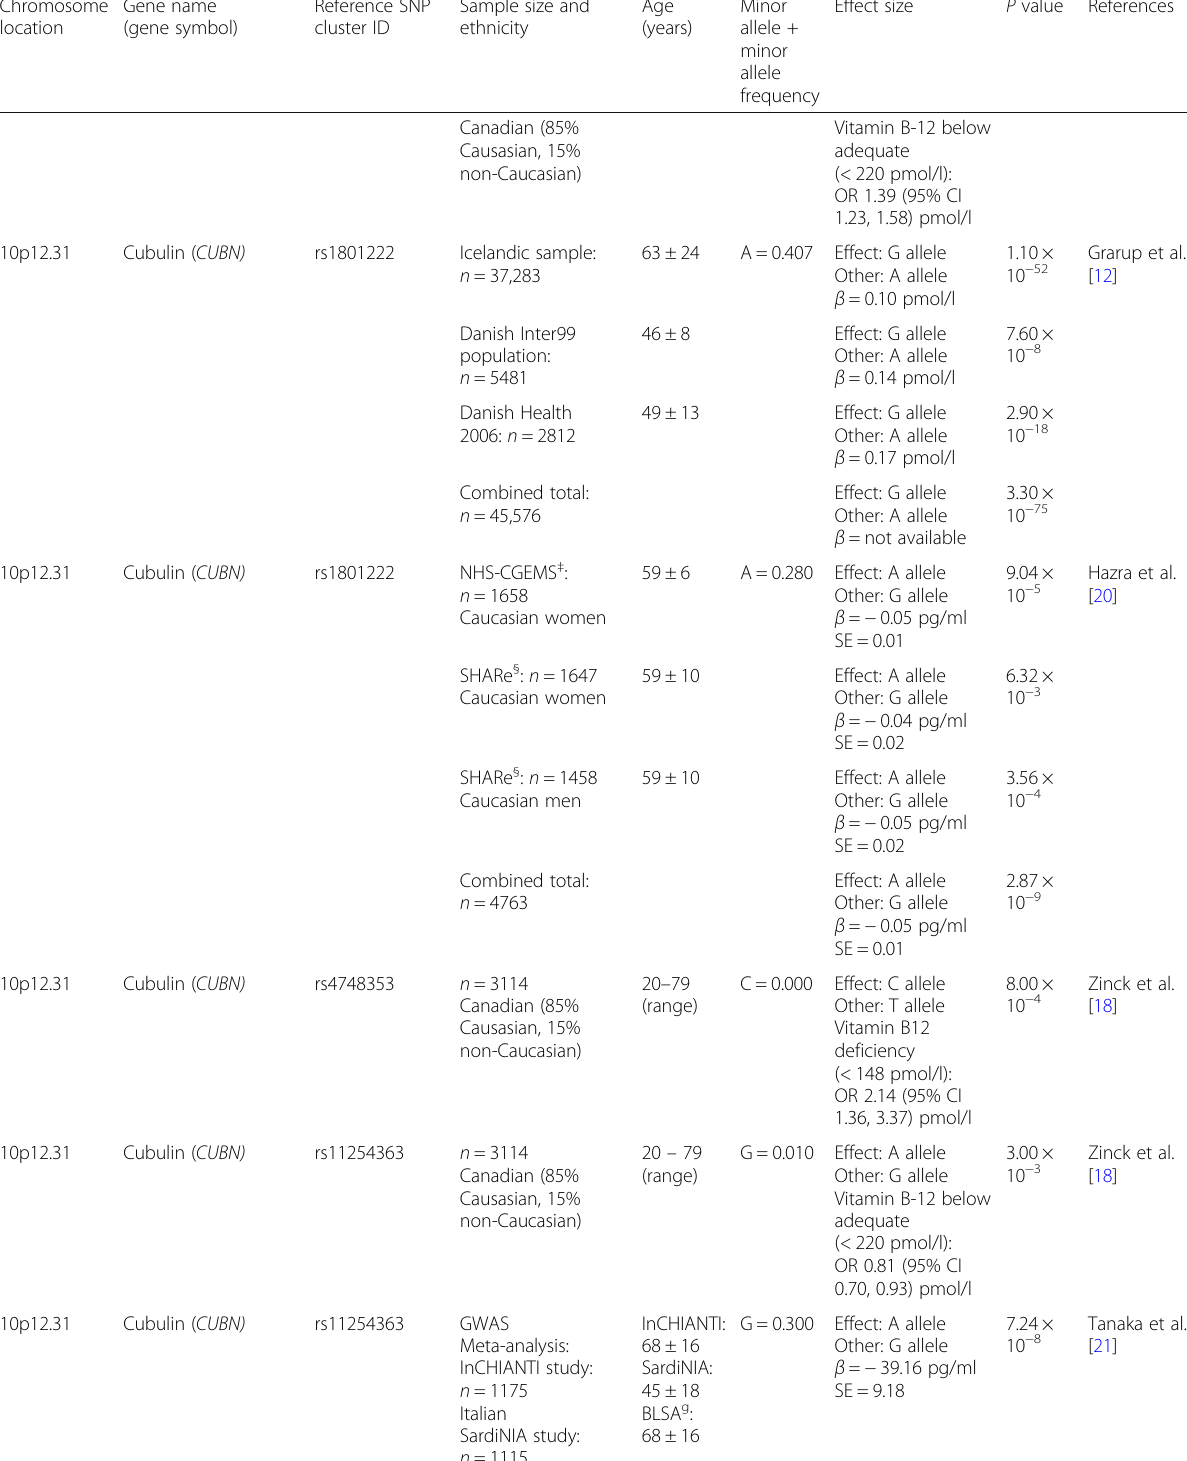
Table 1 Genome-wide association studies showing the association of SNPs with vitamin B12 concentrations. Genome-wide association studies testing the association between SNPs and vitamin B12 concentrations. The chromosome location, gene name, reference SNP cluster ID, sample size and ethnicity, mean age, observed frequency of the minor allele in the population, effect size and P value are shown in the table. The order of SNPs reflects the order of the chromosome location